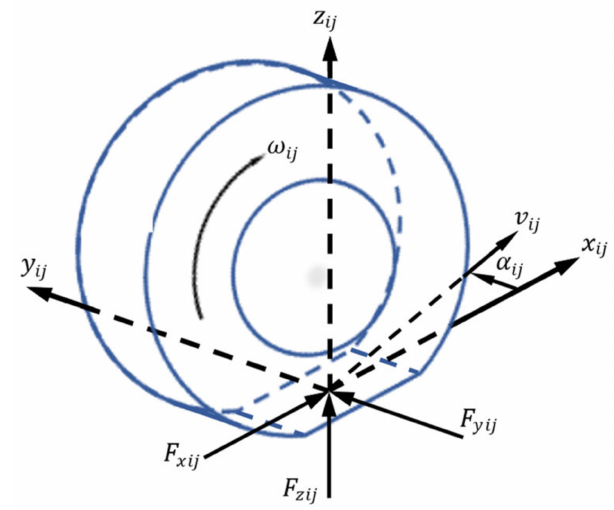
Figure 4. Simplified tire coordinate system.